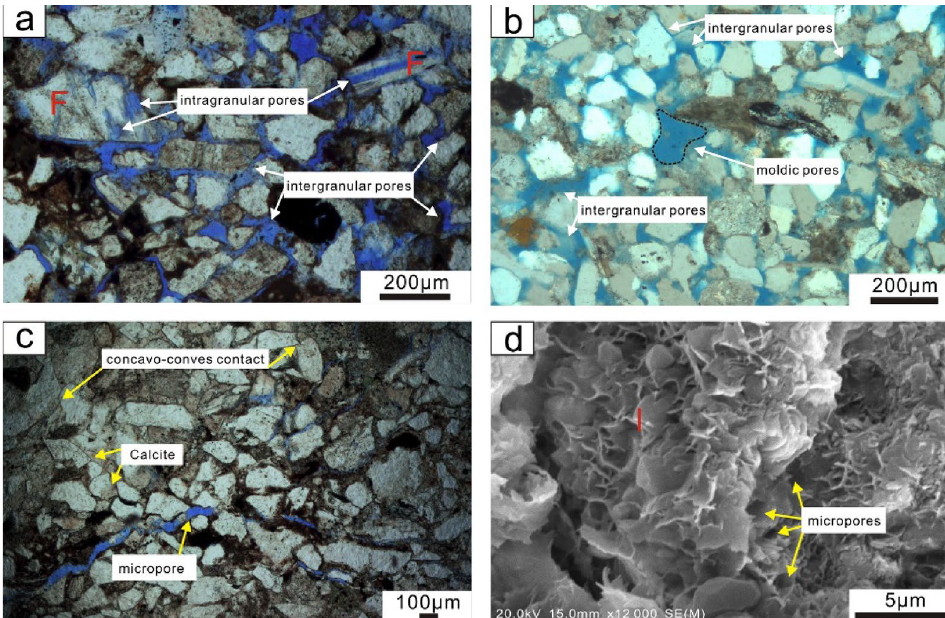
Figure 6. Thin section photomicrographs and SEM images showing details of grain and pore modifications. ( a ) Primary intergranular pores and secondary dissolution intragranular pores resulting from dissolution of feldspars under the microscope, well H2, 2436.6 m, plane-polarized light (PPL); ( b ) Primary intergranular pores and moldic pores resulting from complete dissolution of grains, in well H3, 2702.82 m, PPL. ( c ) Micro-fractures distributed between directionally arranged grains, concavo-conves contact are frequent in this view, well H2, 2433.85 m, PPL; ( d ) Intercrystalline micropores within honeycomb-like illite cements, widths of this types of micropores are usually less than 5 μm, well H4, 2621.5 m, SEM. F = feldspar, I = illite.